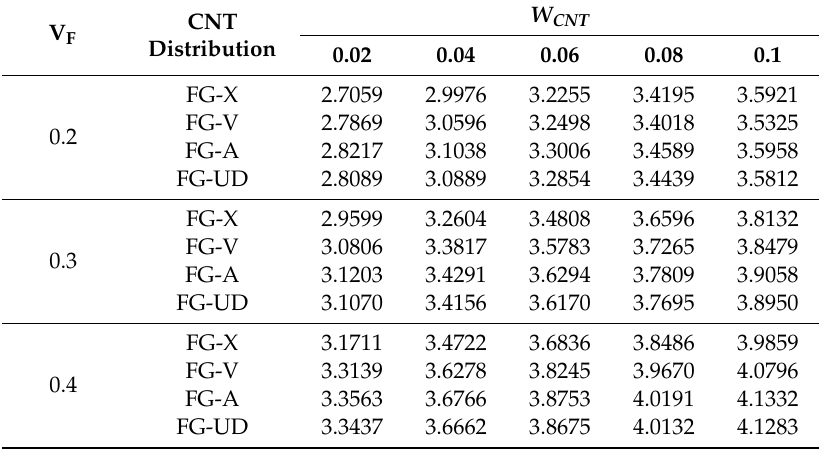
Table 5. E ff ect of CNT pattern on the nondimensional natural frequency of the simply-simply multiscale hybrid composite annular plate (MHCAP) with outer radius to inner radius ratio (b / a = 4), thickness ratio (h / b = 0.2), temperature at bottom surface (T i = 273 [K]), temperature at top surface (T o = 300 [K]), orientation angle of fibers ( θ = π / 4), Winkler coe ffi cient (K w = 0 [N / m 3 ]), Pasternak coe ffi cient (K p = 0 [N / m]), axial load (P = 0 [N]), uniform temperature rise (UTR), and β = 1 for di ff erent weight fractions of CNT and volume fractions of carbon fiber. W CNT V F Distribution